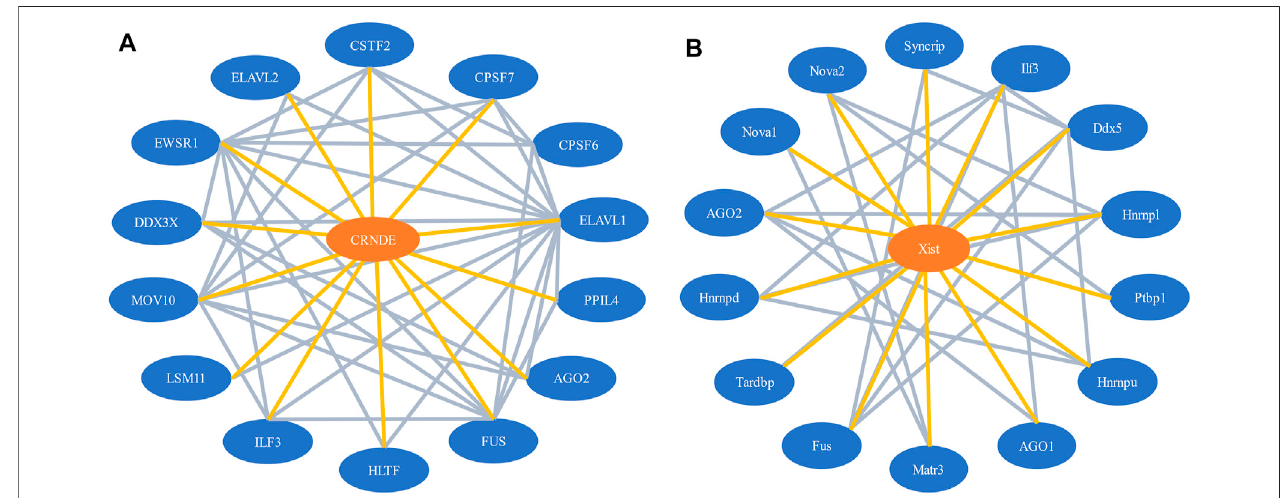
FIGURE1| ApartoftheLPPInetwork. (A) Humandataset.ThenetworkcontainsthelncRNA CRNDE and14interactingproteins; (B) Mousedataset.Thenetwork contains the lncRNA Xist and 14 interacting proteins.